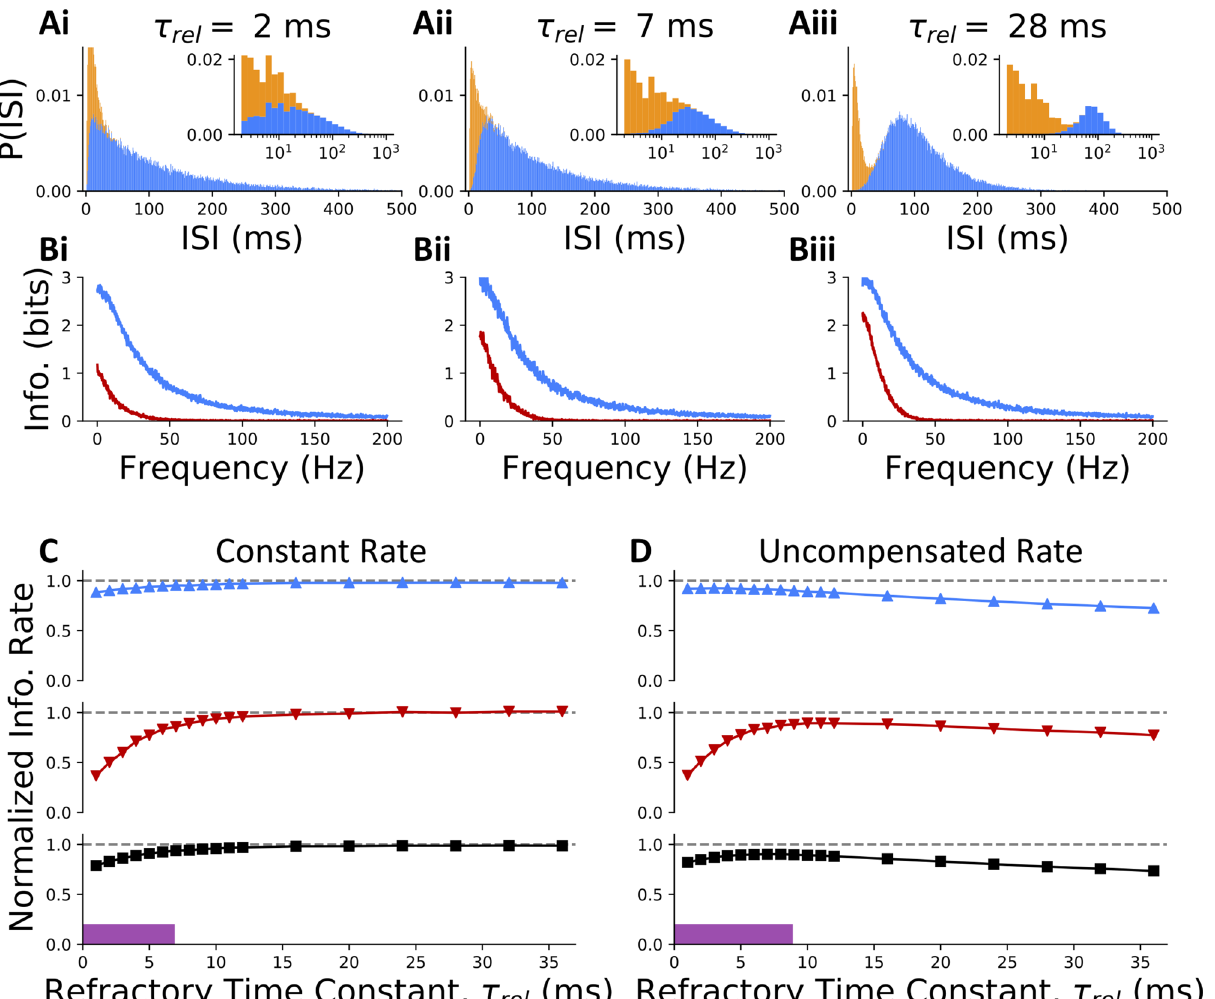
Figure 3. Burst coding despite unimodal inter-spike interval distributions. ( A ) The ISI distribution of the encoding population is plotted for three example relative refractory periods. Distribution is unimodal for very short τ rel = 2 ( i ) and short τ rel = 7 ( ii ) refractory periods, but bimodal for long τ rel = 28 ( iii ) ones (rate compensated data is shown). ( B ) A lower bound on mutual information is plotted as a function of Fourier-frequency for both the driver (blue) and modulator (red) channels. Integrating the lower-bounded information over frequency and summing driver and modulator channels produces estimates of linearly encoded information of ( i ) 131.58 bits/s ( ii ) 148.91 bits/s, and ( iii ) 156.64 bits/s for each distribution shown in ( A ), respectively. ( C ) Normalized Information rate is shown as a function of relative refractory period for the driver channel (blue, up-arrowhead), the modulator channel (red, down-arrowhead) and both channels together (black, square). The purple bar indicates the region of parameter space producing visually unimodal ISI distributions (those exhibiting only a single peak). For each value of the relative refractory period, the firing threshold for neurons in the encoding population was scaled to preserve the same average firing rate for all values of the relative refractory period. ( D ) As in ( C ) but without adjusting cell firing threshold. Normalization in ( C , D ) is by the maximum (over τ rel ) linearly decoded information rate, for perfectly decoded events and